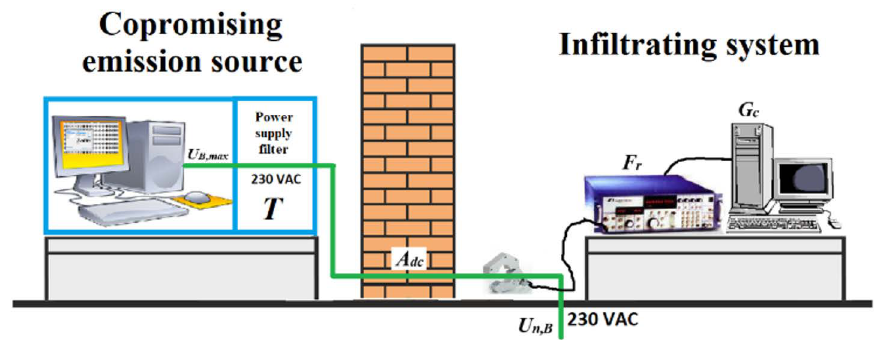
Figure 2. Location of devices affecting the energy budgets of the link between the source of the conducted compromising emission and the output of the infiltrating